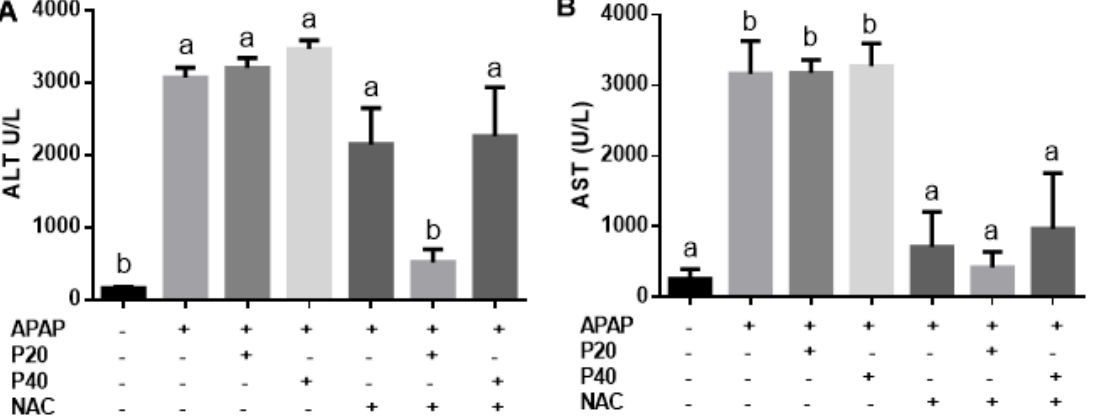
Figure 1. Evaluation of liver function by measuring ALT ( A ) and AST ( B ) concentration in C57BL/6 mice intoxicated with paracetamol (500 mg/kg). Statistical analysis was performed using one-way analysis of variance and Tukey’s post-test. Different letters (a, b) indicate significant difference between groups ( p < 0.05), whereas the same letters indicate no significant difference between groups ( p > 0.05). (+) Presence or ( − ) absence of paracetamol, piperine 20 mg/kg, piperine 40 mg/kg, N-acetylcysteine. ALT: alanine aminotransferase; AST: aspartate aminotransferase.